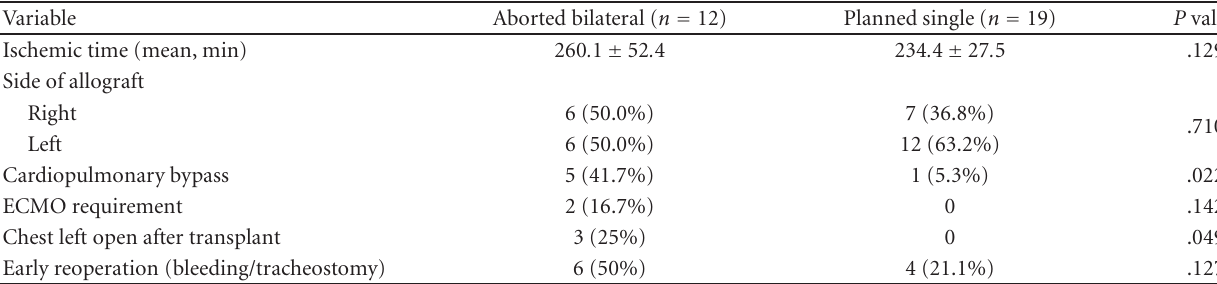
Table 1: Operative data.